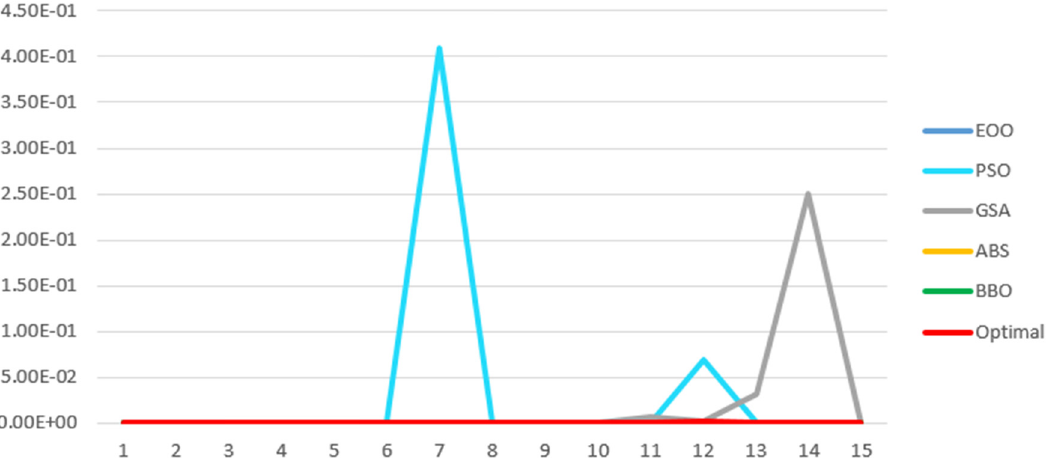
Figure 3: A comparison of the optimal value of the unimodal function test with results of the proposed method EOO, PSO, GWO, BBO, GSA, and ABC algorithms result.